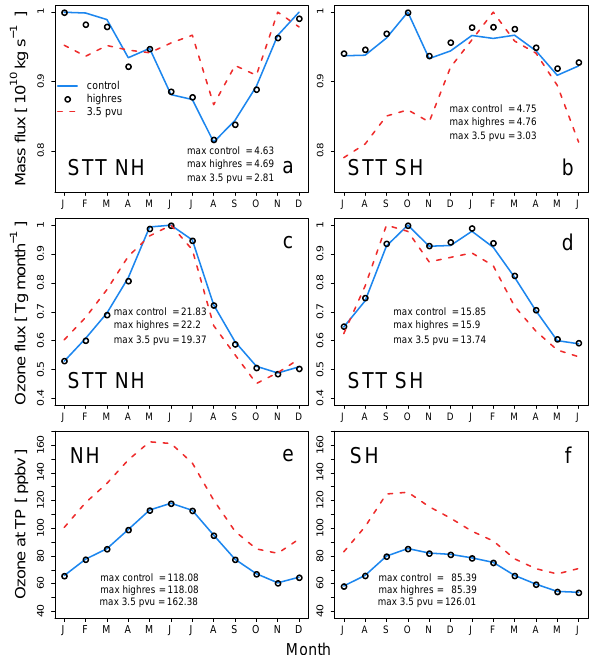
Fig. 20. Seasonal cycles of hemispherically integrated STT fluxes of mass (top) and ozone (middle) for the year 2010. The three dif- ferent data sets (“control”, “highres”, and “3.5pvu”) are described in Sect. 5. In the bottom row, the average mixing ratio of ozone at the corresponding control surface is shown. The seasonal cycles are scaled to their maximum values shown within the individual figures, facilitating the comparison of amplitude and shape of the cycles.